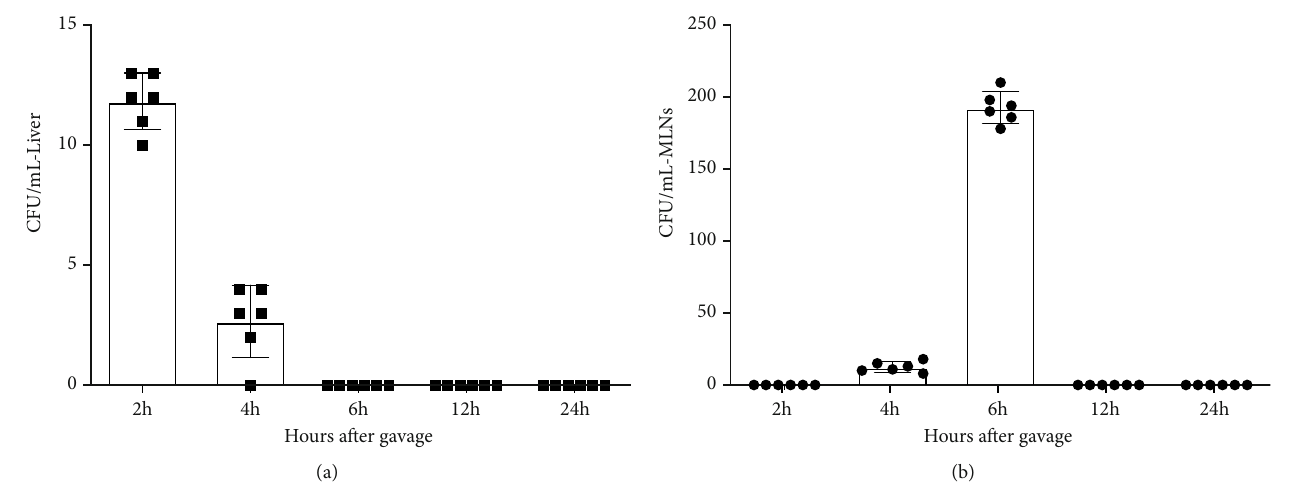
Figure 7: Transient translocation of L. lactis MG1363 FnBPA + (pValac::dts:: IL-4 ) and L. lactis MG1363 FnBPA + (pValac:: IL-10 ) was detected in the liver and MLNs. The organs were collected 2 h, 4 h, 6h, 12h, and 24 h after bacterial administration, macerated in 0.9% saline, and plated on selective medium. After 24 h of incubation at 30 ° C, the bacterial colonies in the plates corresponding to the liver (a) and MLNs (b) were counted. All results are presented as colony forming units (CFU) per mL. The data are shown as the mean of three independent experiments ( n = 6